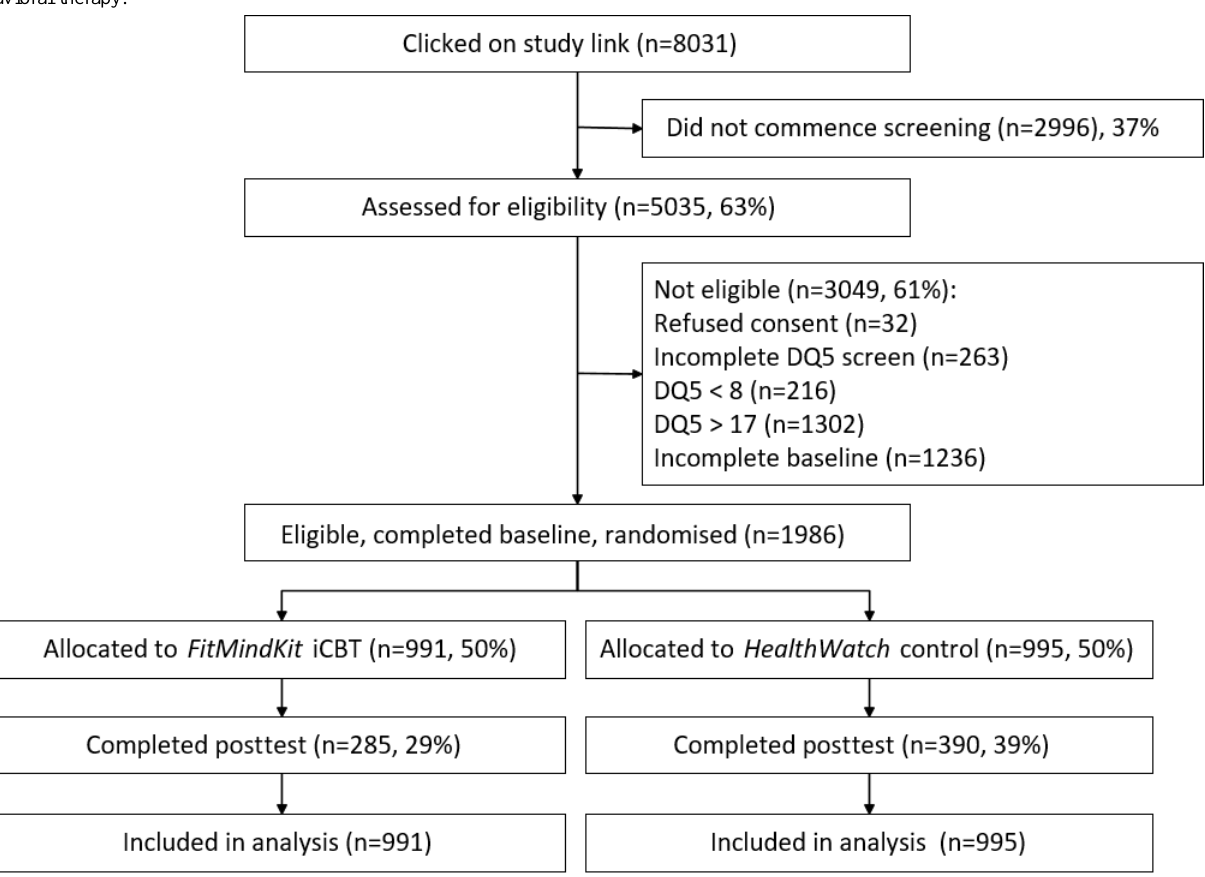
Figure 2. CONSORT (Consolidated Standards of Reporting Trials) flow diagram. DQ5: Distress Questionnaire-5; iCBT: internet-based cognitive behavioral